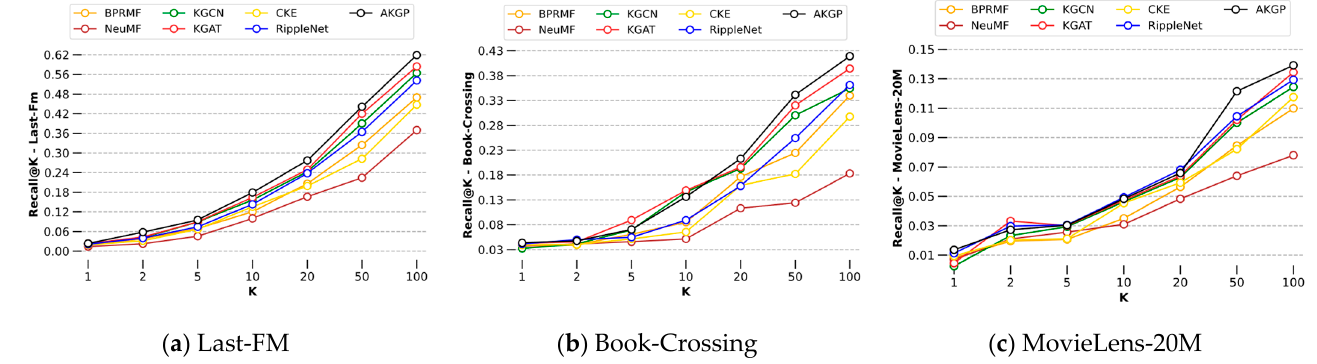
Figure 7. The results of Recall in Top-K recommendation. ( a ) Results using the Last-FM dataset. ( b ) Results using the Book-Crossing dataset. ( c ) Results using the MovieLens-20M dataset.